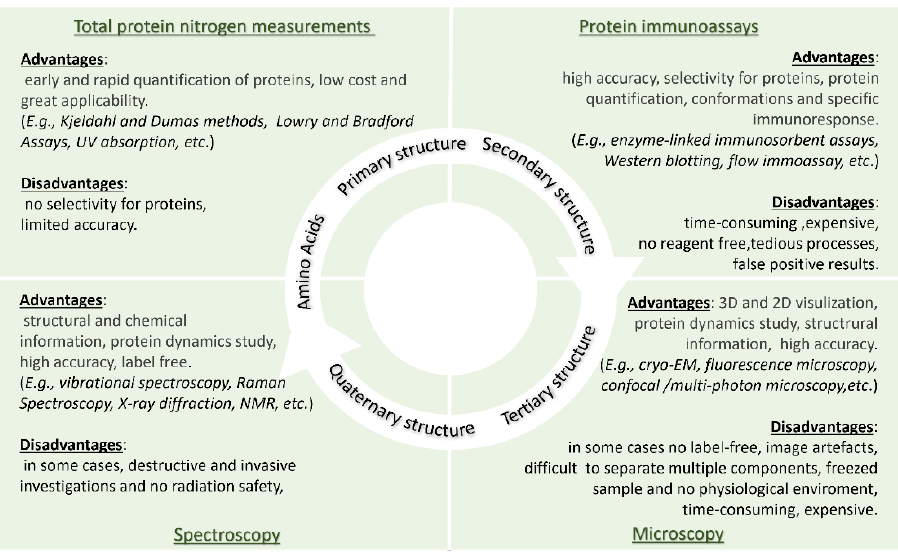
Figure 2. Schematic overview about the advantages and disadvantages of main techniques for protein characterization.